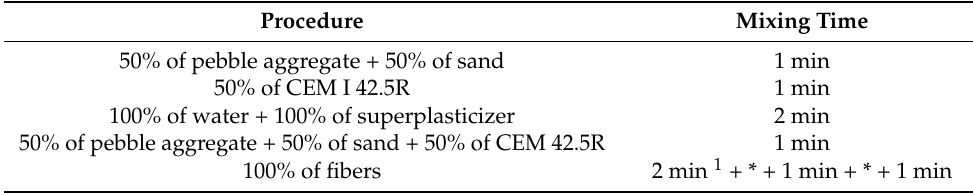
Table 4. Mixing procedure.